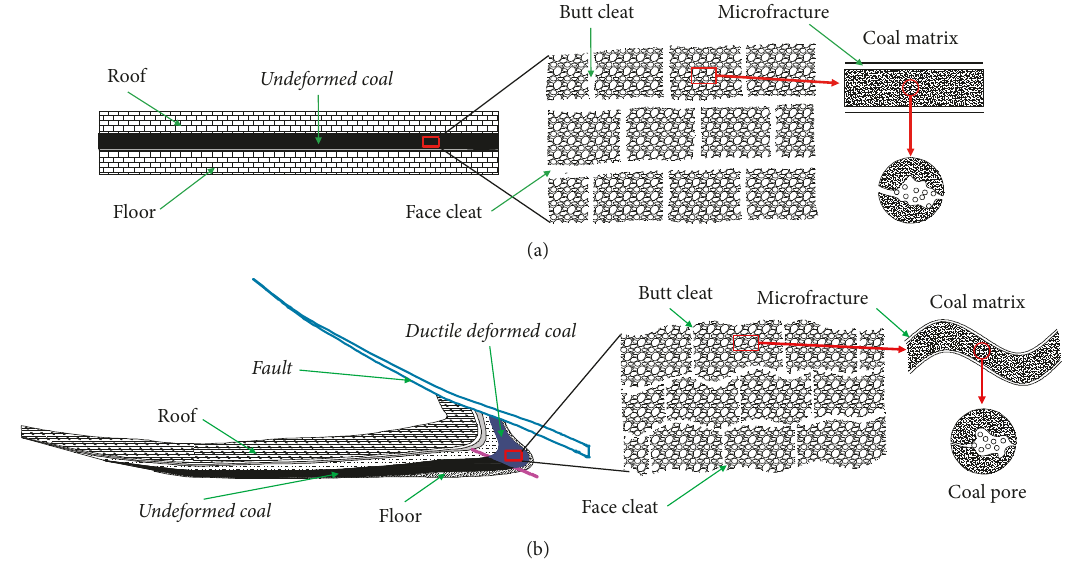
Figure 10: Influence of tectonic deformation on CO 2 entrapment in Haishiwan